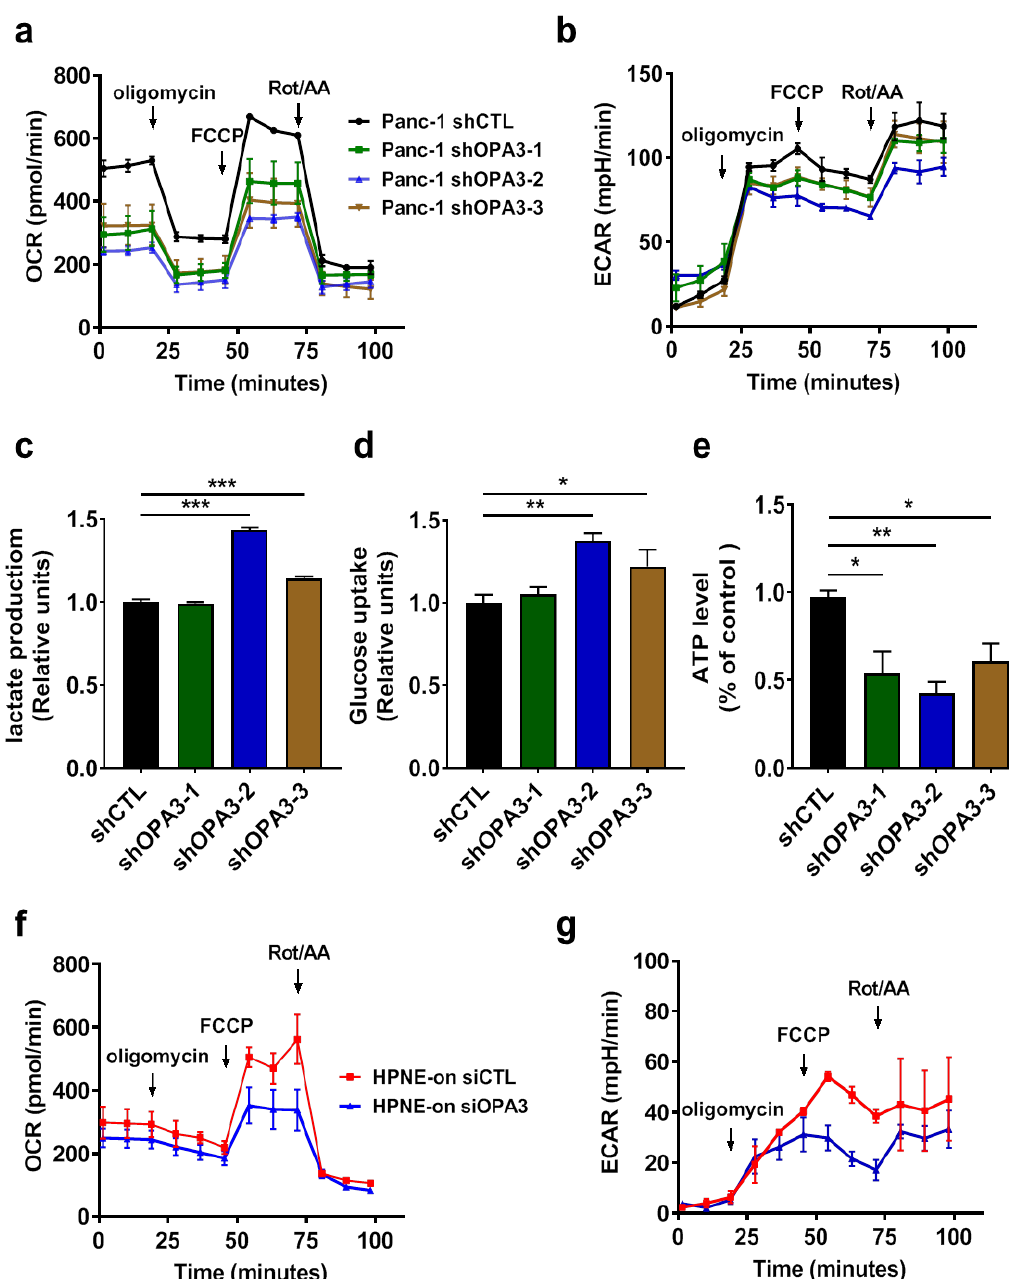
Figure 3. Silencing of OPA3 expression alters mitochondrial function in Panc-1 cells: ( a , b ) Real-time measurement of OCR and ECAR for Panc-1 cells using the Seahorse analyzer. ( c , d ) Lactate and glucose contents were quantified in culture medium of Panc-1 OPA3-shRNA cells. ( e ) Intracellular ATP content was quantified in Panc-1 OPA3-shRNA cells. ( f , g ) Real-time measurement of OCR and ECAR for HPNE / K-ras G12D cells using the Seahorse analyzer. HPNE / K-ras G12D cell line was transfected with control siRNA (siCTL) or OPA3-siRNA for 24 h and then incubated with doxycycline for additional 24 h. Statistics: data are mean ± S.E.M. (n = 3); one-way ANOVA followed by Dunnett post hoc test (compared to “shCTL”) for ( c – e ). * p < 0.05, ** p < 0.01 and *** p < 0.001. Abbreviations: AA: antimycin A; ECAR: extracellular acidification rate; FCCP: carbonyl cyanide p-trifluoromethoxyphenylhydrazone; OCR: oxygen consumption rate; OPA3: optic atrophy protein 3; Rot: rotenone; shCTL: control shRNA; shOPA3: shRNA against human OPA3; siCTL: control siRNA; and siOPA3: siRNA against human OPA3.